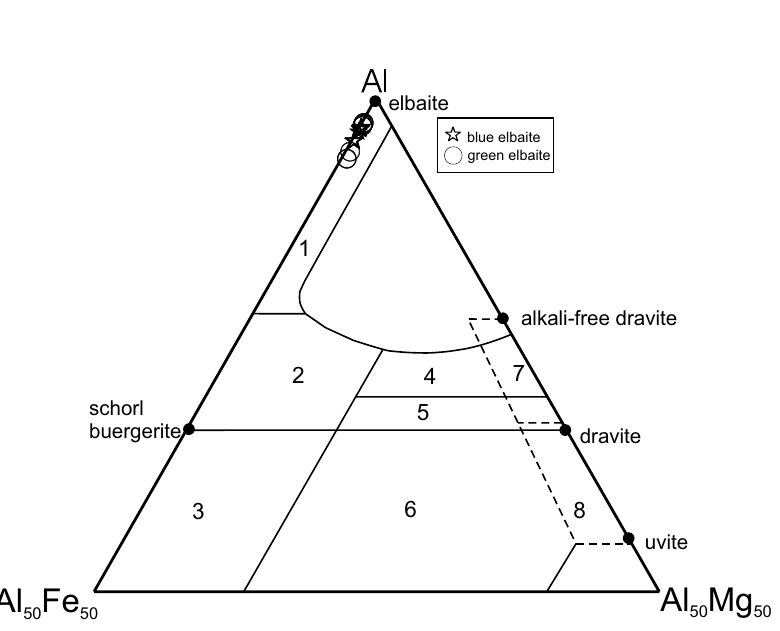
Fig. 3 – Al-Fe(t)-Mg diagram showingfields of the compositional range of tourmalines from different rock types proposed by Henry and Guidotti (1985). Field 1 is typical of tourmalines from Li-rich granitoid pegmatites and aplites.